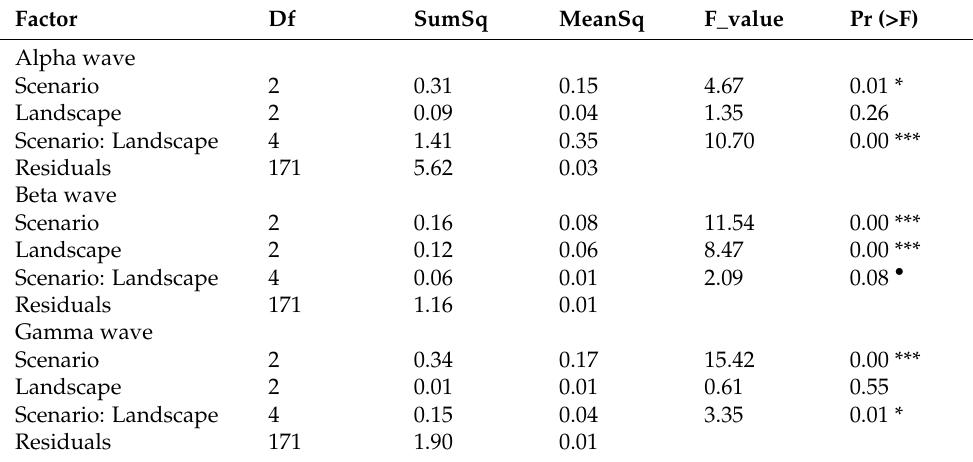
Table 1. Results of ANOVA.